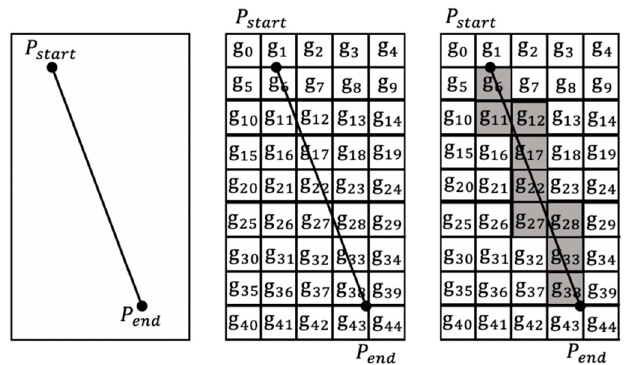
Figure 7. After gridding, the shaded area represents the grid for counting the number of times the ship has passed through the cross section.